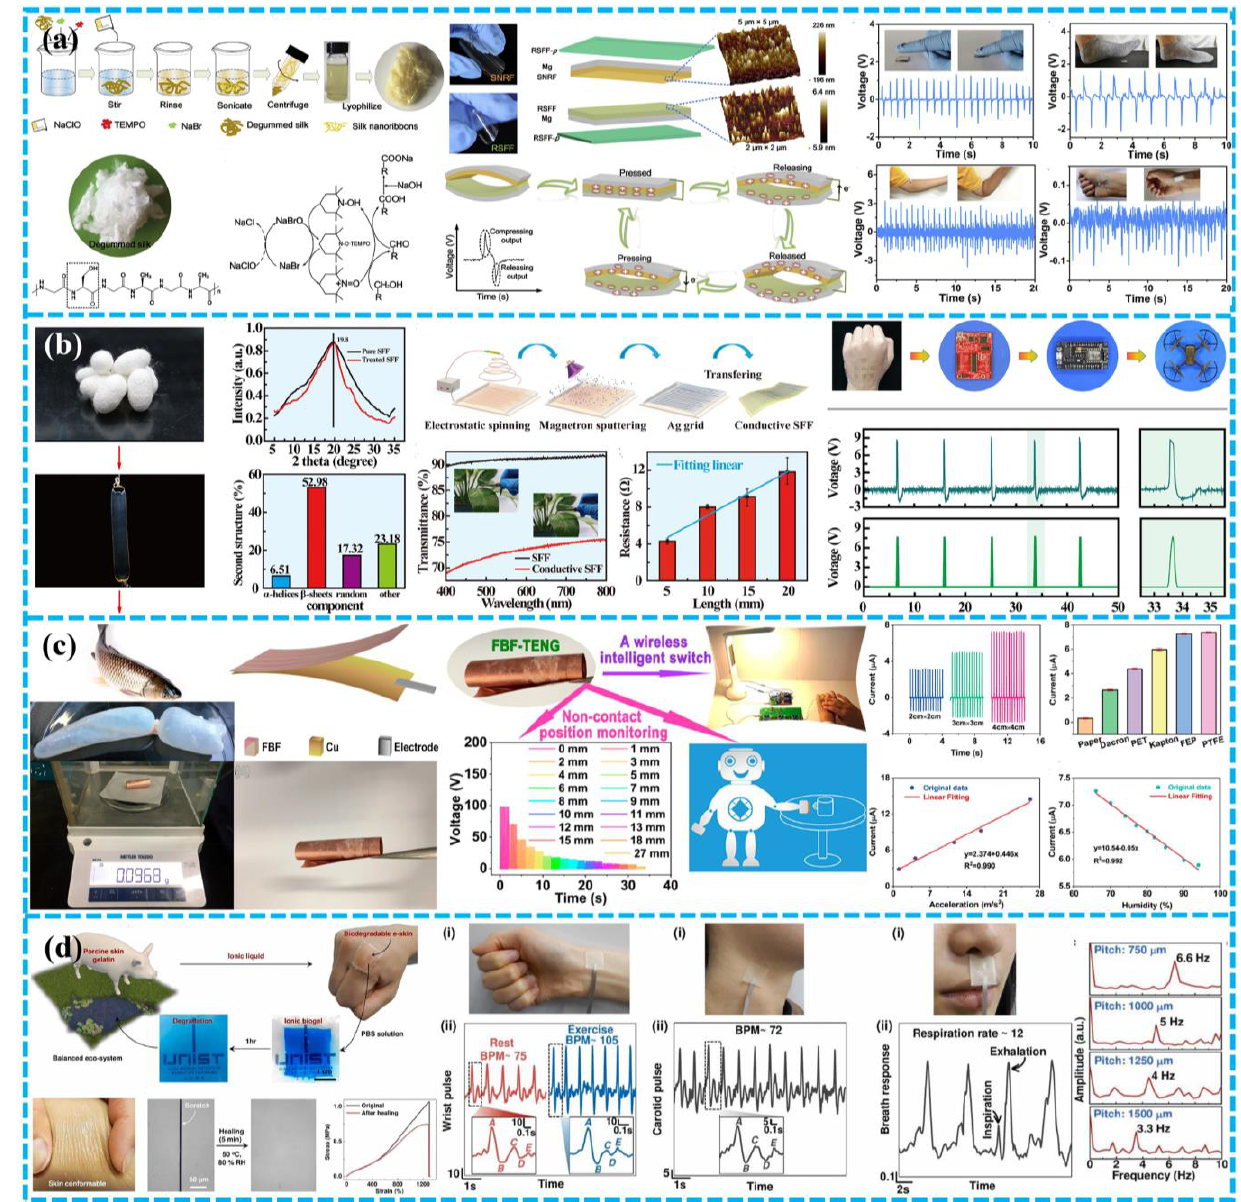
Figure 10. BD-TENGs based on animal extracts for self-powered active sensing system. ( a ) A pulse-driven bio TENG based on silk nanoribbons; a schematic illustration of silk nanoribbon (SNR) preparation process; real-time monitoring of different parts of the body. Reproduced with permission [112], Copyright 2020, Elsevier Ltd. ( b ) A transparent, stretchable, and degradable protein electronic skin for biomechanical energy harvesting and wireless sensing; illustration of the SFF preparation and property characterization; application of tactile sensing based on the SFF-STENG in the internet of things by WLAN. Reproduced with permission [101], Copyright 2020, Elsevier B.V. ( c ) An intelligent electronic skin based on the biocompatibility and biodegradability of flexible single electrode fish bladder film TENG (FBF-TENG). Reproduced with permission [113], Copyright 2021, American Chemical Society. ( d ) A super-stretchable, tough, healable, and biodegradable triboelectric device with microstructure and ion crosslinked bio-gel; schematic of the balanced full cycle of an eco-system with zero waste footprint: manufacturing of the porcine skin gelatin-based ionic bio-gel, utilisation as biodegradable device, degradation of the food colored ionic bio-gel upon disposal in PBS buffer (pH ≈ 7.4) solution at 37 °C temperature; applications of the iSBTENG to low-frequency human vital sign monitoring and high-frequency acoustic wave sensing. Reproduced with permission [102], Copyright 2022, Elsevier Ltd.